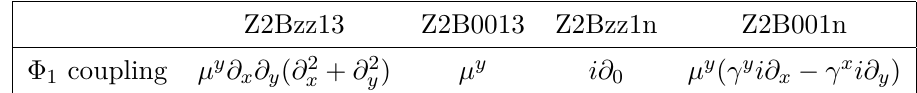
Table 4 . Yukawa couplings of the single adjoint Higgs fields which realize the symmetry fraction- alization of the proximate Z2B spin